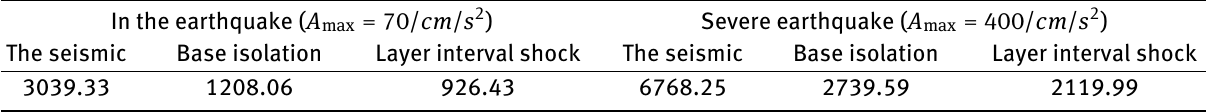
Table 3: Base shear force of structure In the earthquake ( A max = 70/ cm / s 2 ) The